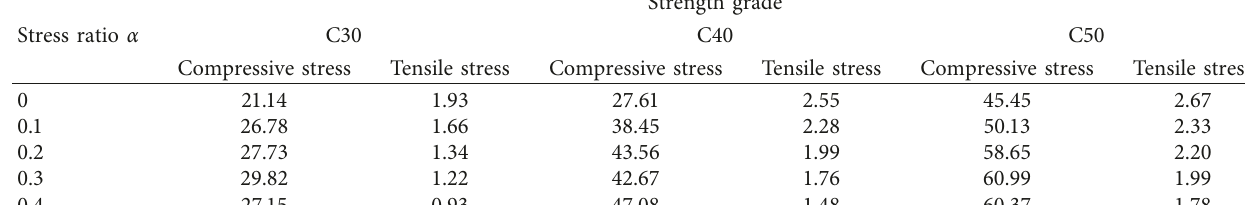
Table 2: The eigenvalues of biaxial loading stress-strain curves of plain concrete with different strengths. Stress ratio